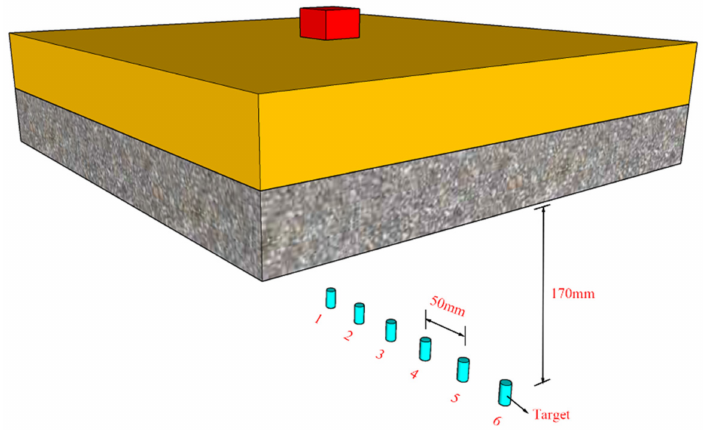
Figure 24. The spatial position of the measuring